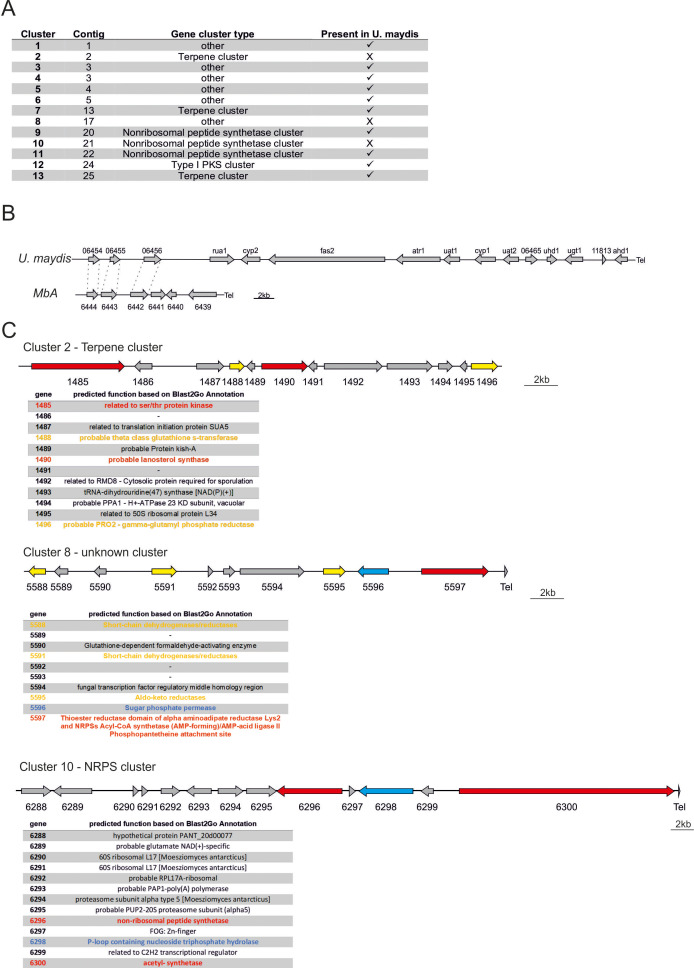
Secondary metabolite gene in the genome of MbA.(A) Predicted secondary metabolite clusters in the genome of MbA. Most clusters have unpredictable functions, three belong to the type of terpene or nonribosomal peptide synthetase types and one is a polyketide synthetase cluster type I. (B) The gene cluster encoding for production of ustilagic acid, a well-studied secondary metabolite of smut fungi (Teichmann et al., 2007), is not present in the genome of MbA. (C) Out of the 13 predicted secondary metabolite clusters, three are unique to MbA. Cluster 2 is predicted to encode a terpene, cluster 8 is a cluster of unknown function, and cluster 10 is predicted as NRPS cluster. Core biosynthetic genes are highlighted in red, additional biosynthetic genes in yellow, and transport-related genes in blue, based on AntiSMASH predictions.